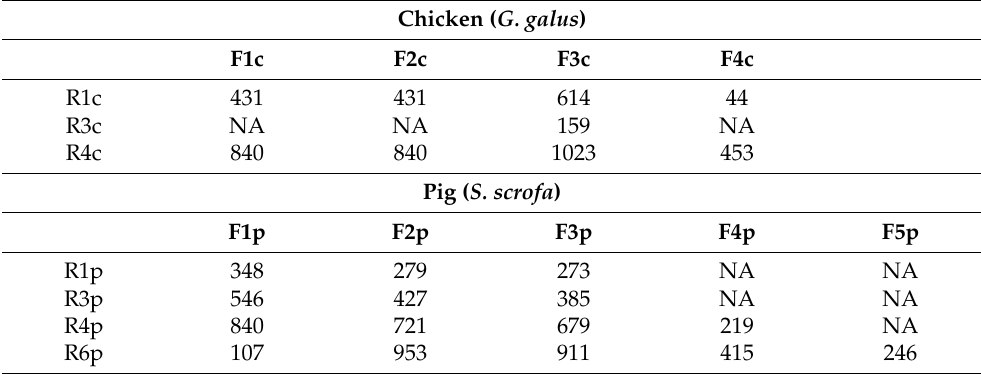
Table 2. Length (bp) of possible amplification product with the selected